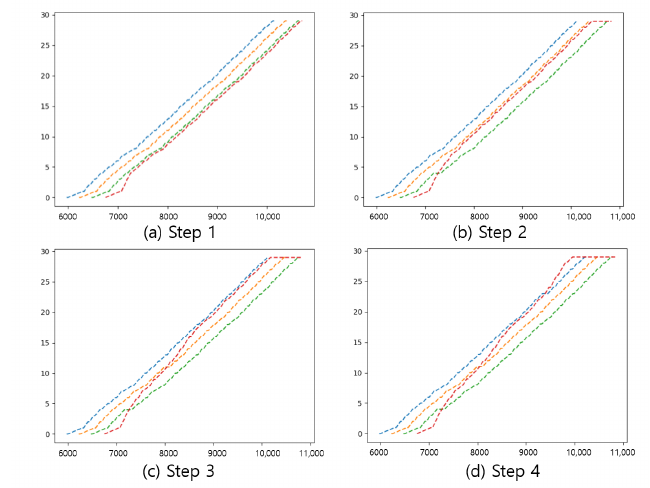
Figure 2. An example of sequential decision-making. ( a ) Initial step, ( b ) Step 2, ( c ) Step 3, ( d ) Final